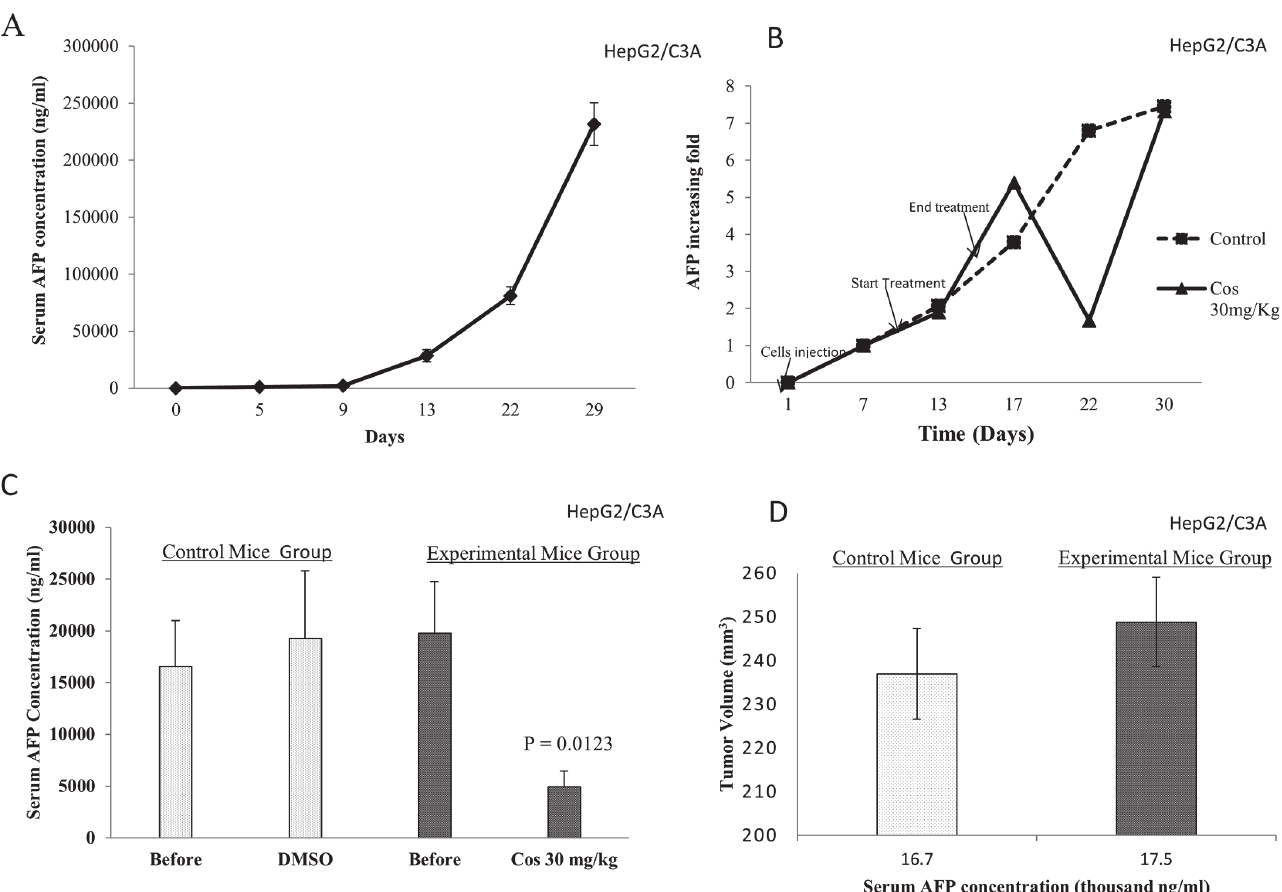
Fig 6. In vivo effect of costunolide on AFP secretion in NSG mice. NSG mice were inoculated with HepG2/C3A cells and treated as described in Materials and Methods. (A) AFP kinetics in the mice blood after cell injection. (B) A representative figure of the effect of costunolide 30 mg/kg on AFP secretion in the NSG mice blood. (C) Mean and standard error of AFP secretion in the NSG mice blood before and after treatment with 30 mg/kg costunolide. The control group received the vehicle. (D) Mean tumor size as a function of the AFP secretion in the NSG mice blood before and after treatment.